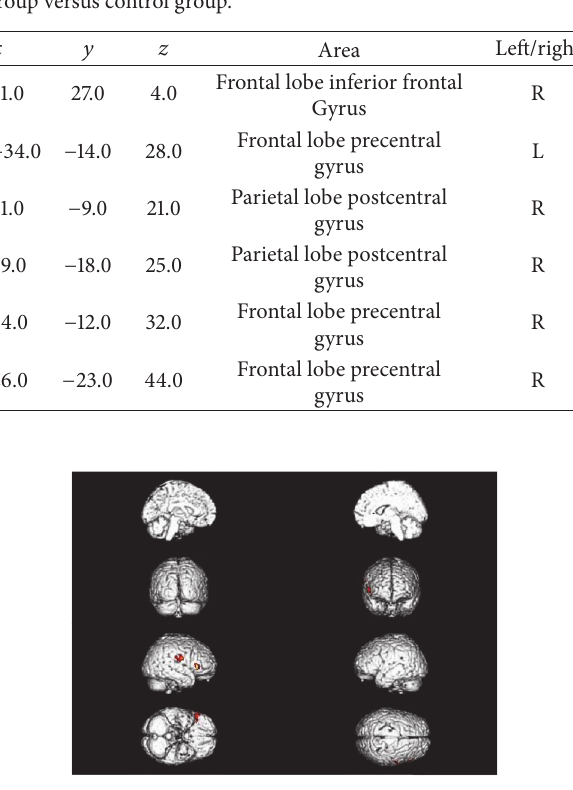
Figure 2: SPM hypometabolic maps comparing typical CS group and the control